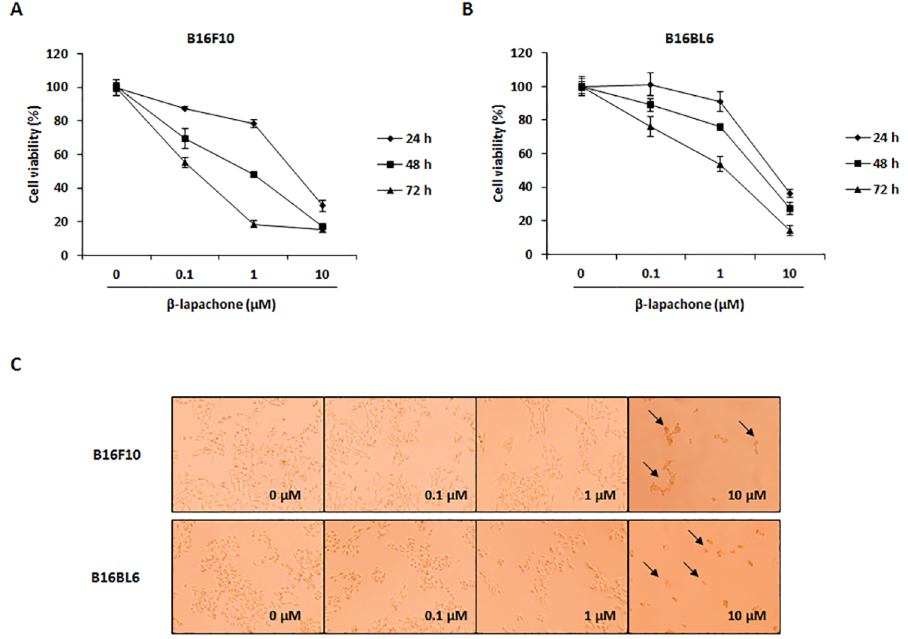
Fig 1. Effect of β -lapachone on the cell viability of metastatic melanoma cells. (A and B) Cell viability of β -lapachone-treated B16F10 (A) and B16BL6(B) cells. The cells were seededat a density of 5 × 10 3 cells/well in 96-wellmicroplates and then treated with variousconcentrations of β -lapachone for 24–72 h. After incubation, cell viabilitywas determined by WST assay. Values are the means ± SD of data from three independent experiments. (C) Morphology of β -lapachone-treated cells. B16F10 and B16BL6cells were treated with β -lapachone for 48 h. The morphologicalchangesof the cells were observedunder a phase- contrast microscope (magnification 200 ×